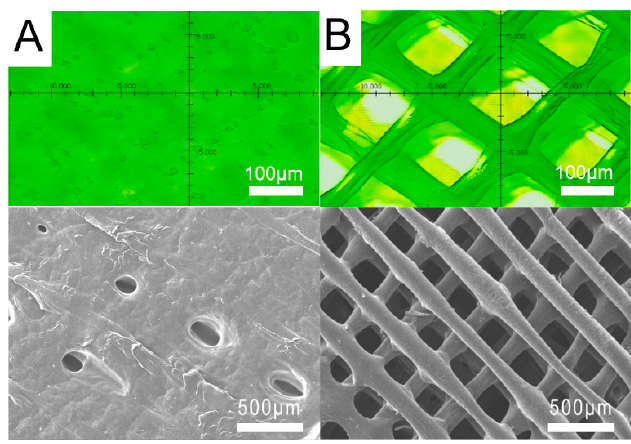
Figure 9. Profile projector and FESEM images of parts manufactured with PCL/DCM ratios of ( A ) 5 g/7.2 mL, ( B ) 5 g/6.8 mL.